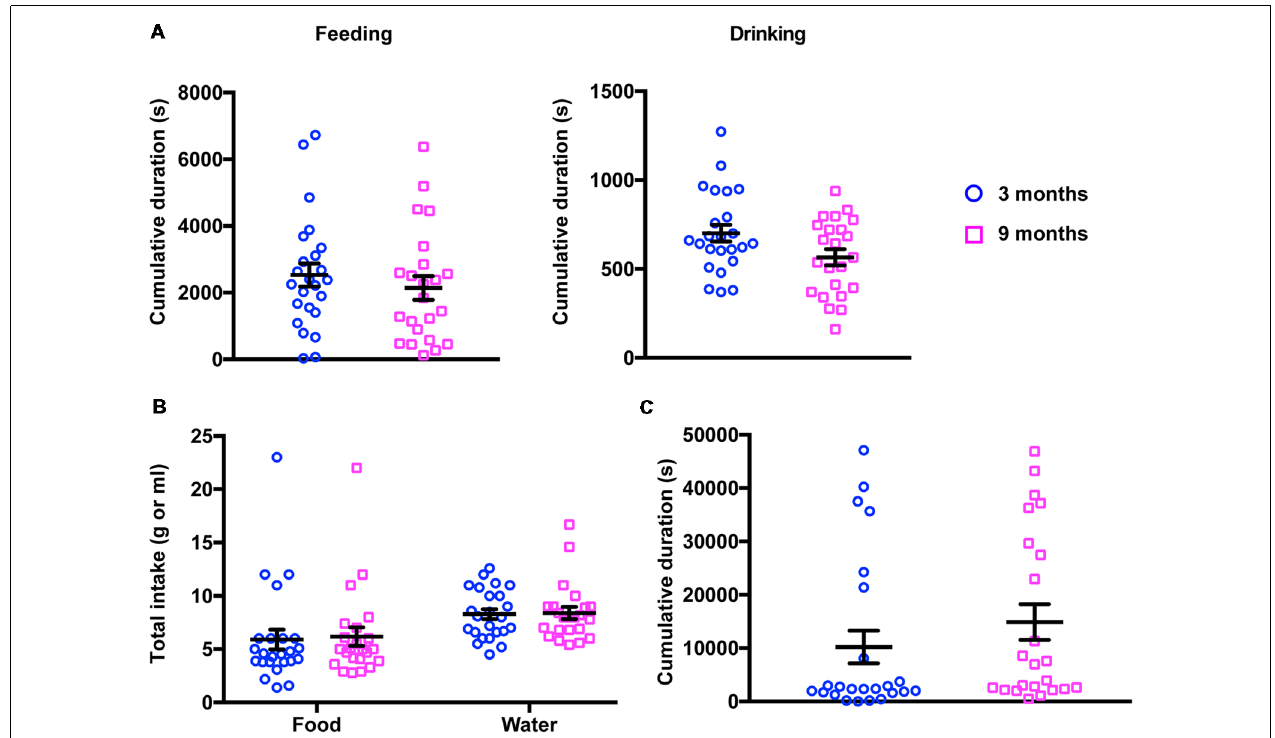
FIGURE 1 | Results of 20-h activity monitoring in the PhenoTyper. (A) No differences were detected in the total time spent feeding (left panel) and drinking (right panel) between 3- and 9-month-old mice (3 months, feeding 2,530 ± 349.7 s, drinking 701.1 ± 46.49 s; 9 months, feeding 2,142 ± 356.0 s, drinking 565.8 ± 44.60 s). (B) Young and middle-aged mice showed a similar food and water consumption (3 months, food 5.91 ± 0.94 g, water 8.29 ± 0.47 ml; 9 months, food 6.18 ± 0.87 g, water 8.39 ± 0.57 ml). (C) The cumulative time spent in the shelter did not change in 3- vs. 9-month-old mice (3 months, 10,210 ± 3,070 s; 9 months, 14,870 ± 3,359